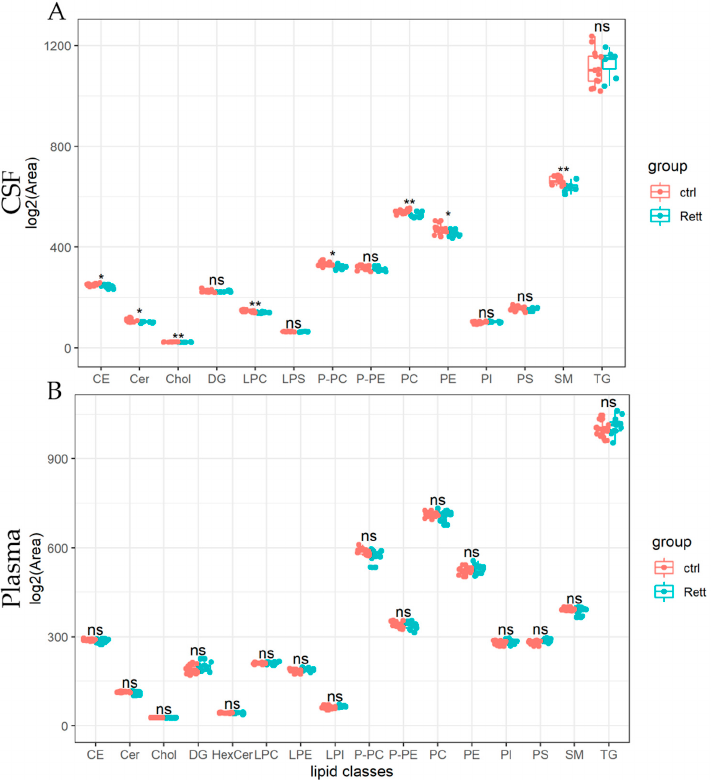
Figure 3. Univariate analysis of lipid classes analyzed from CSF and plasma samples of RTT patients compared to healthy controls. Lipidome data obtained from UHPLC-MS/MS were analyzed using R and the lipidr package. Data is shown as log 2 of total area count. Box plots represent lipid classes detected in the CSF ( A ) and plasma ( B ) of RTT patients and controls and are calculated as sum of lipid species detected in one lipid class. CE (Cholesterol Ester), Cer (Ceramide), Chol (Cholesterol), DG (Diacylglycerol), HexCer (Hexosylceramide), PC (Phosphatidylcholine), PE (Phosphatidylethanolamine), PI (Phosphatidylinositol), PS (Phosphatidylserine), LPC (Lyso-PC), LPE (Lyso-PE), LPI (Lyso-PI), PC-O (Ether-linked PC), PE-P (Plasmalogens of PE), SM (Sphingomyelin), TG (Triacylglycerol); *-FDR adjusted p < 0.05 by Wilcoxon rank-sum test, **-FDR adjusted p < 0.01 by Wilcoxon rank-sum test, ns-not significant.